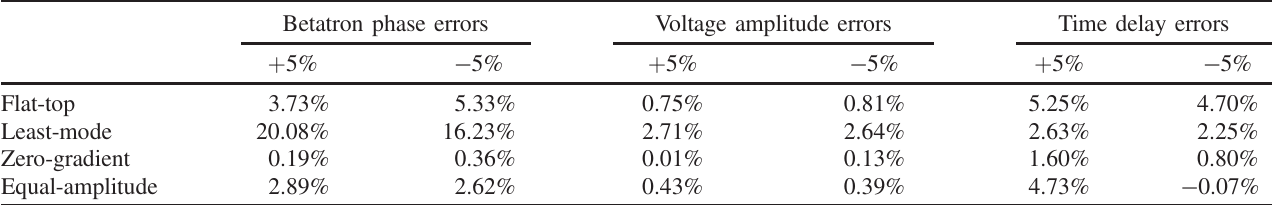
TABLE IV. Calculated relative emittance growth due to errors in the beam optics and rf control system.